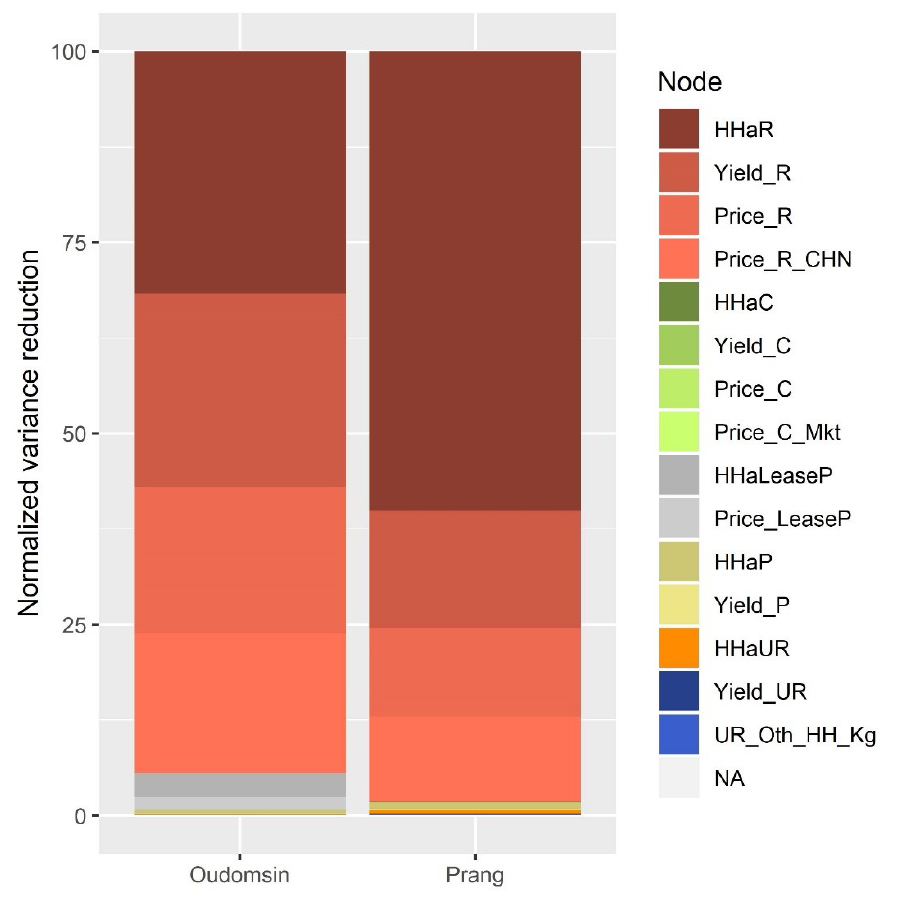
Figure A1.4: Sensitivity of net household agricultural production income to other variables (nodes) in the BN, calculated as the percent reduction in variation of the node when the value of another node is